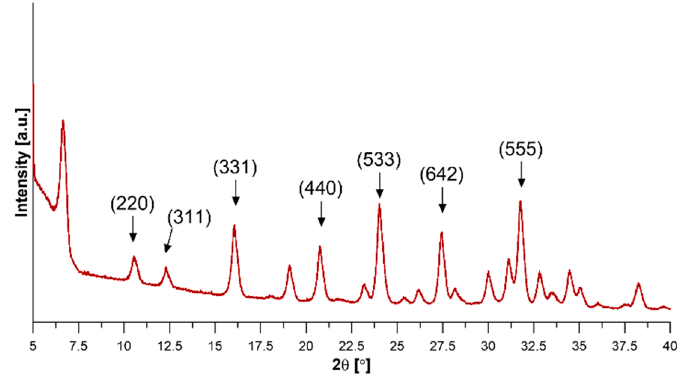
Figure 1. XRD spectra of NaY zeolite.